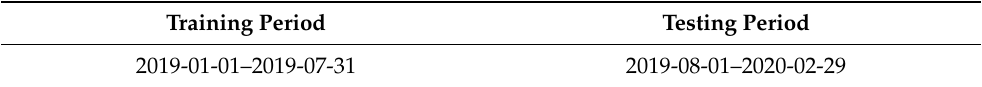
Table 6. Training and testing periods for Occupancy Forecasting application.